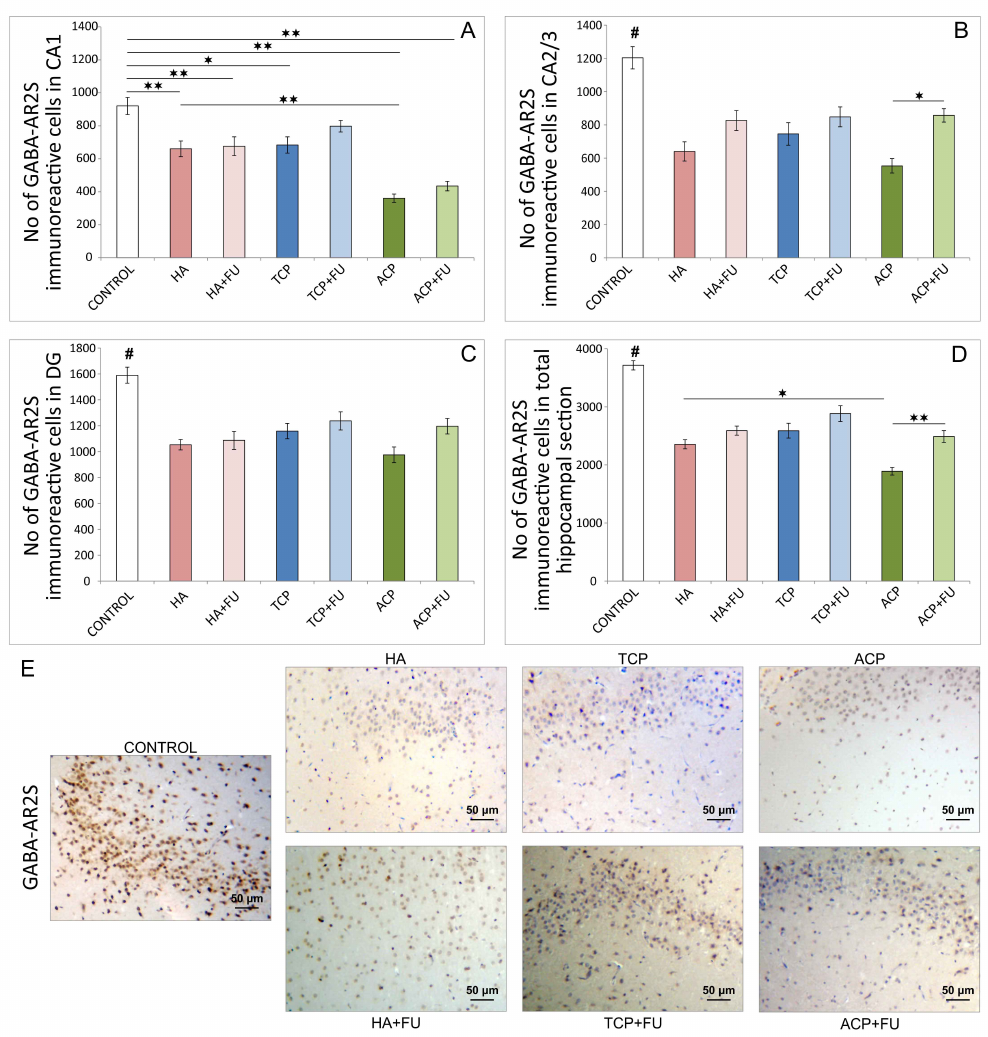
Fig. 6. Quantitative immunohistochemical analysis of GABA-AR2S-positive cells in the hippocampus (6 per group) and the distribution in CA1 region (A), CA2/3region(B),DG(C),andthetotalsectionofthehippocampus(D),and(E)therepresentativeimagesofGABA-AR2SIHCstaining(originalmagnification x20). HA – hydroxyapatite; HA + FU – hydroxyapatite and Filipendula ulmaria extract; TCP – tricalcium phosphate hydrate; TCP + FU – tricalcium phosphate hydrate and Filipendula ulmaria extract; ACP – amorphous calcium phosphate; ACP + FU – amorphous calcium phosphate and Filipendula ulmaria extract. The graph bars present mean ± SEM, * represents a significant difference p < 0.05, ** represents a significant difference p < 0.01, # represents a significant difference ( p < 0.01) between control and all other